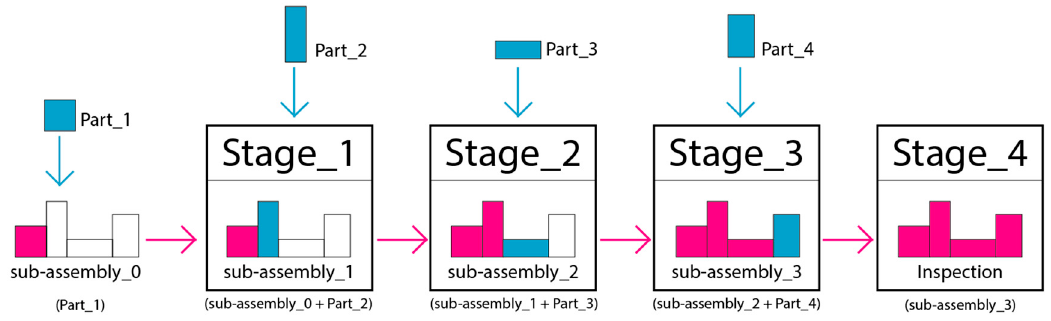
Figure 9. Case study process schema.